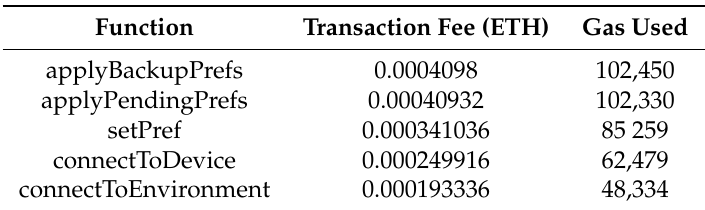
Table 3. User contract